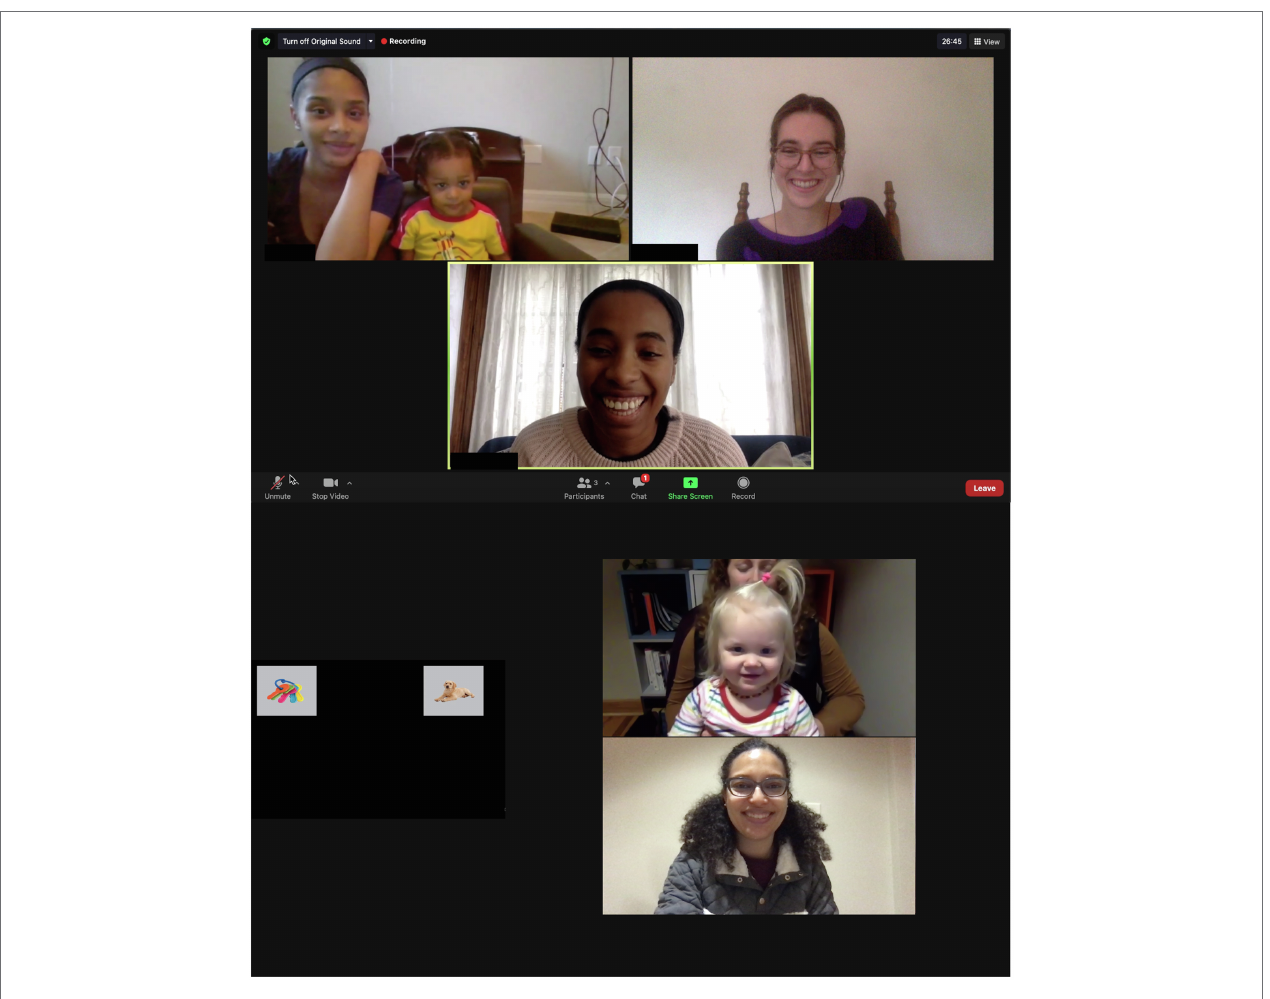
FIGURE 1 | Facebook advertisement used for